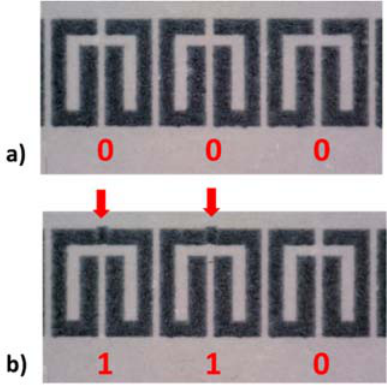
Figure 7. ( a ) Identical resonators pre-programmed all to a logic ‘0’ and ( b ) re-connected resonators (programmed to a logic ‘1’).